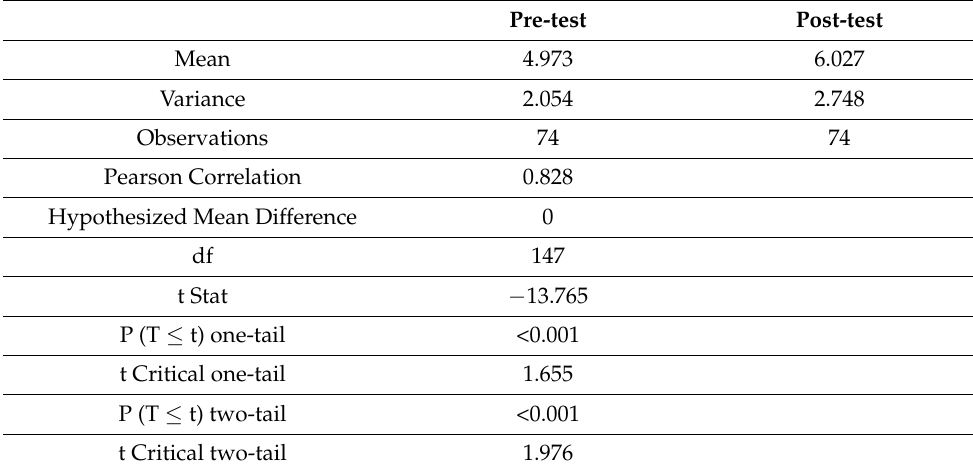
Table 8. t -test: Paired two samples for means of group A.